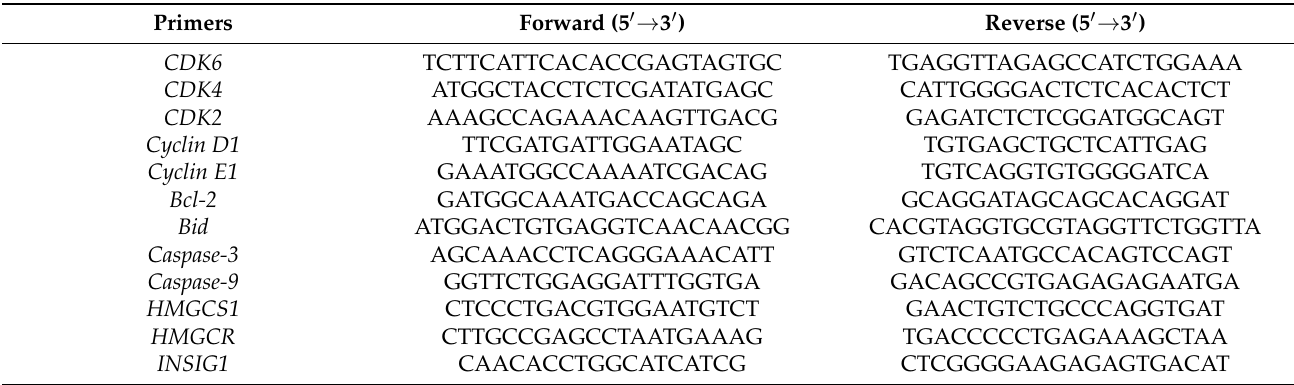
Table 1. List of primer sequences used for